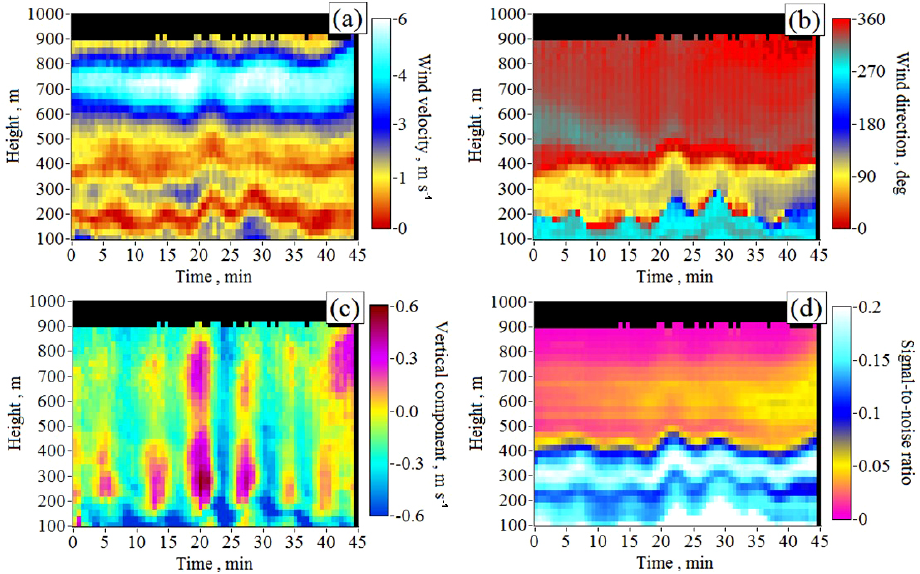
Figure 11. Spatio-temporal distributions of the wind speed (a) , wind direction angle (b) , vertical component of the wind vector (c) and signal-to-noise ratio (d) obtained from measurements of the Stream Line lidar on 14 August 2015 starting from